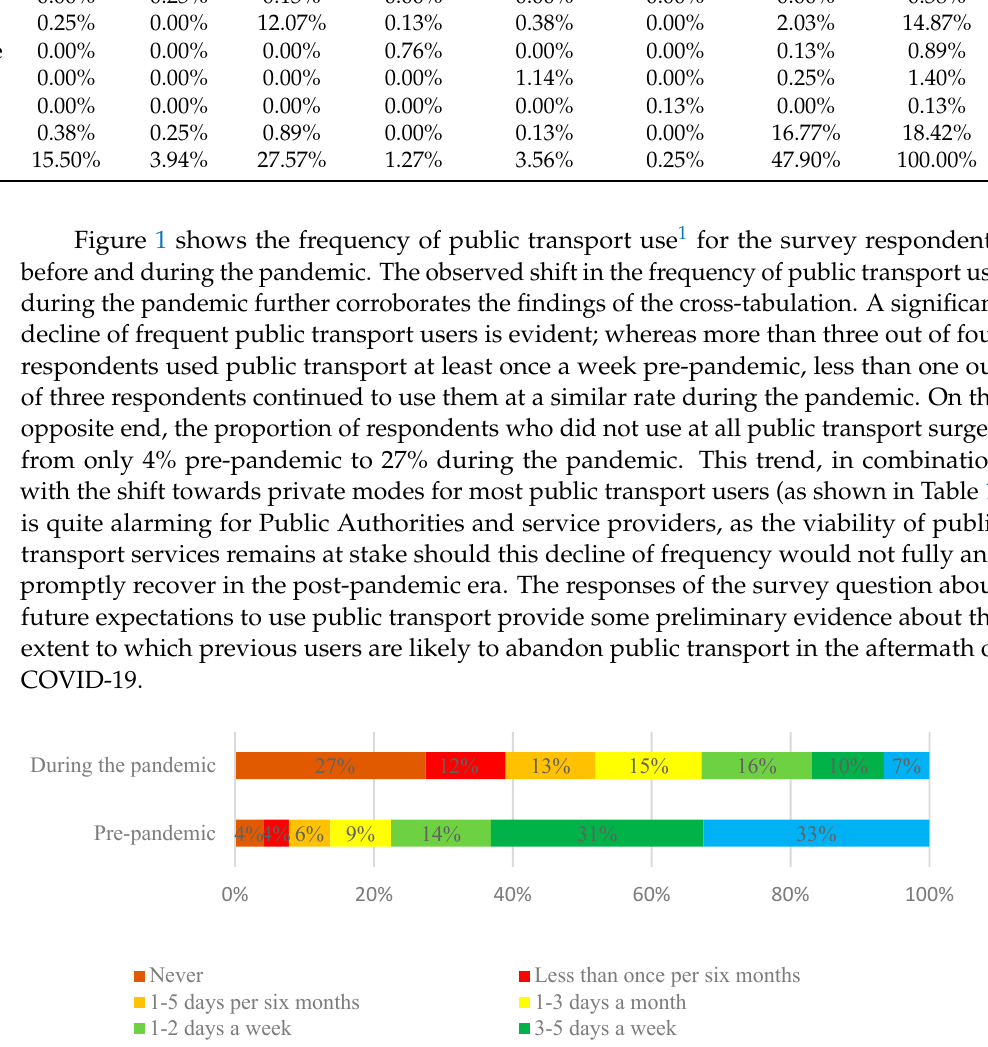
Figure 1. Trip frequency with public transport bus before and during the pandemic.